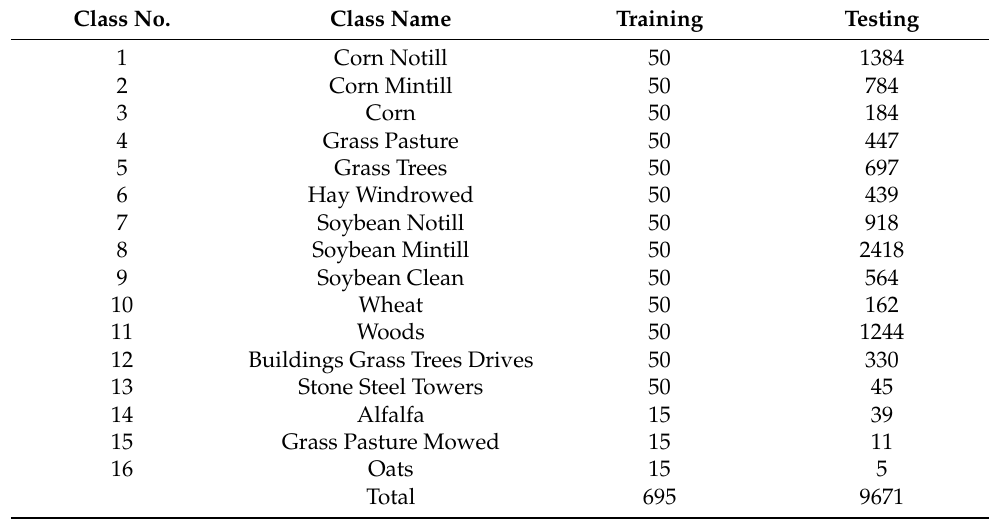
Table 3. Land-cover classes with corresponding standard training and testing pixels on Indian Pines dataset.